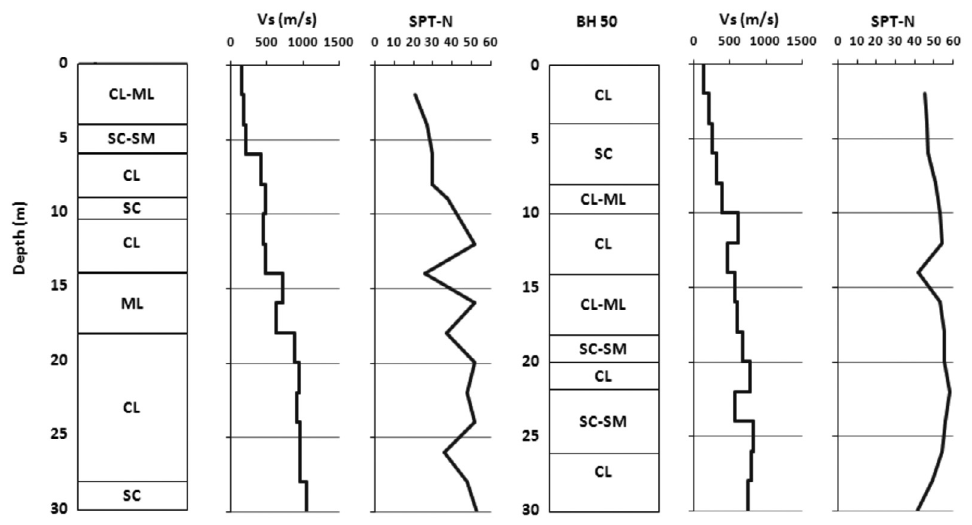
Figure 4. Geology, shear wave velocity and SPT-N profiles at two different sites (Soils are classified based on The Unified Soil Classification System. CL: Lean clay; CL-ML: Silty clay; ML: Lean silt; SC: Clayey sand; SC-SM: Silty, clayed sand).